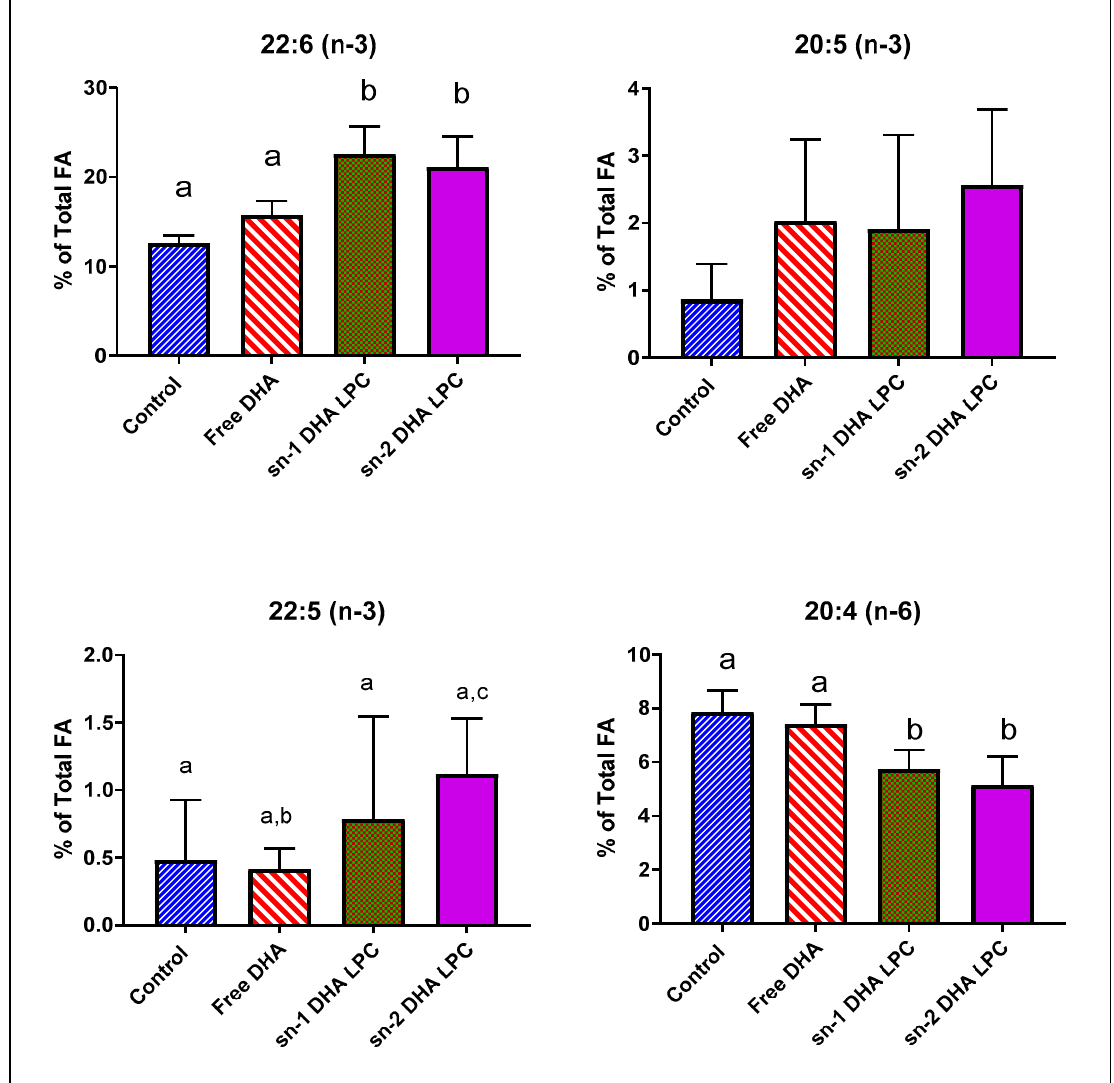
Figure 2. E ff ect of dietary free (unesterified) DHA, sn-1 DHA-LPC, and sn-2 DHA LPC on mouse retinal FA. Normal male mice (C57 BL / J6, 16-week-old) were gavaged daily with 1 mg DHA in the form of free DHA, sn-1 DHA LPC, or sn-2 DHA LPC in 80 µ L corn oil for 30 days. Retinal FA composition was analyzed by GC / MS. Only the values for arachidonic acid and the omega-3 FA are shown here (mean ± SD, 8 animals / group). The total FA composition is shown in Table 2. Bars without Table 2. Effect of free DHA, sn-1 DHA LPC, and sn-2 DHA LPC on fatty acid composition of mouse retina. common superscripts are significantly di ff erent from each other ( p < 0.05) by a one-way ANOVA